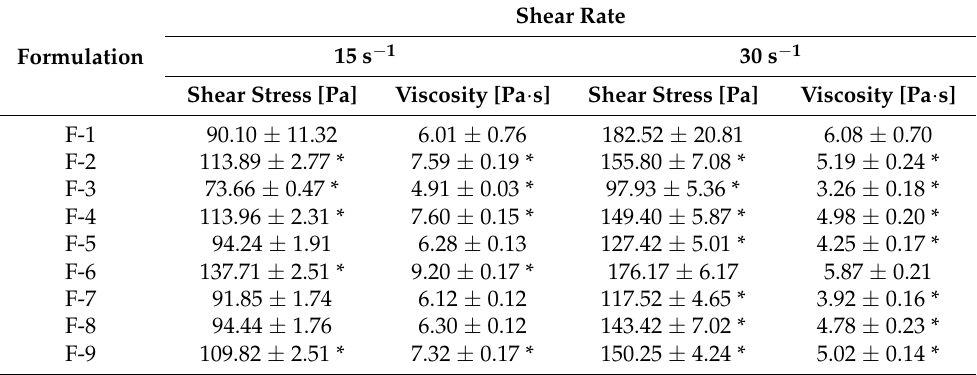
Table 6. Viscosity parameters of formulations determined at 32 °C at two selected shear rates. Formulation